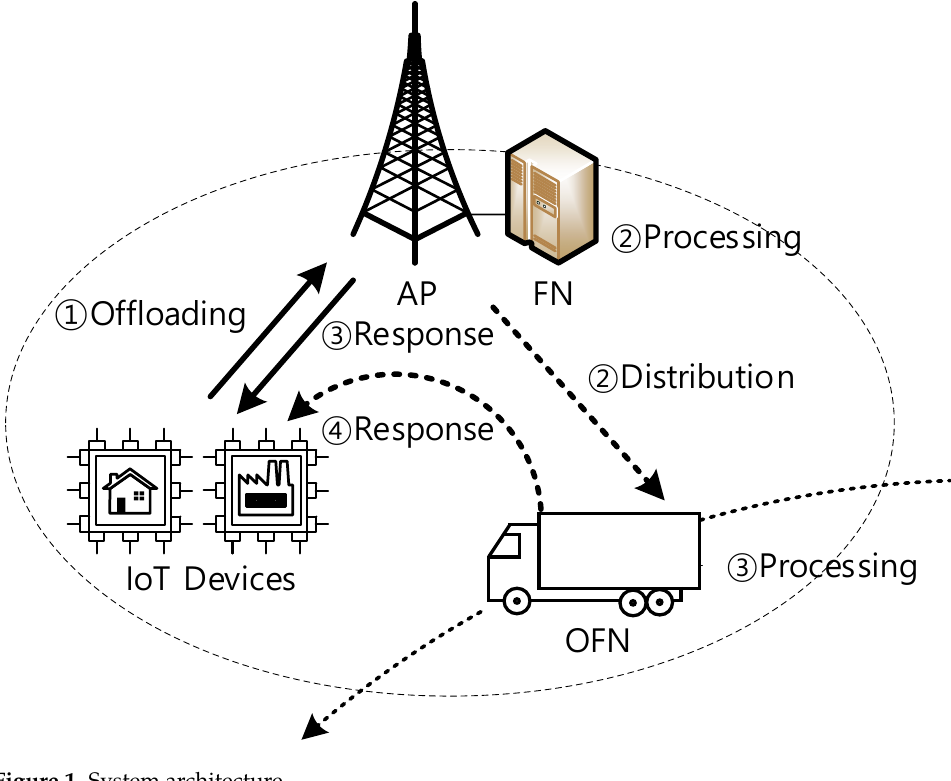
Figure 1. System